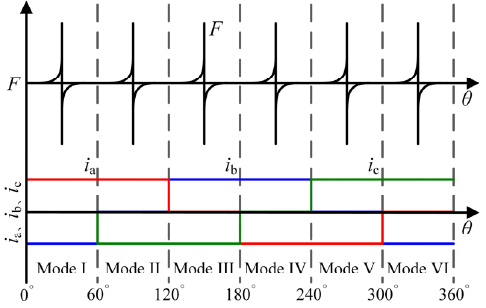
Figure 6. Flux-linkage function and reference current waveform.